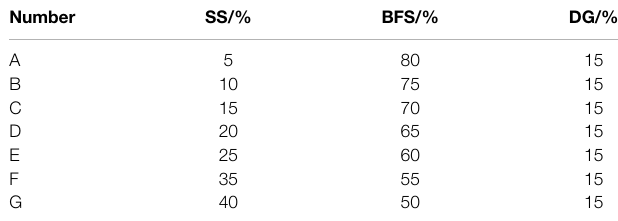
Frontiers in Materials |